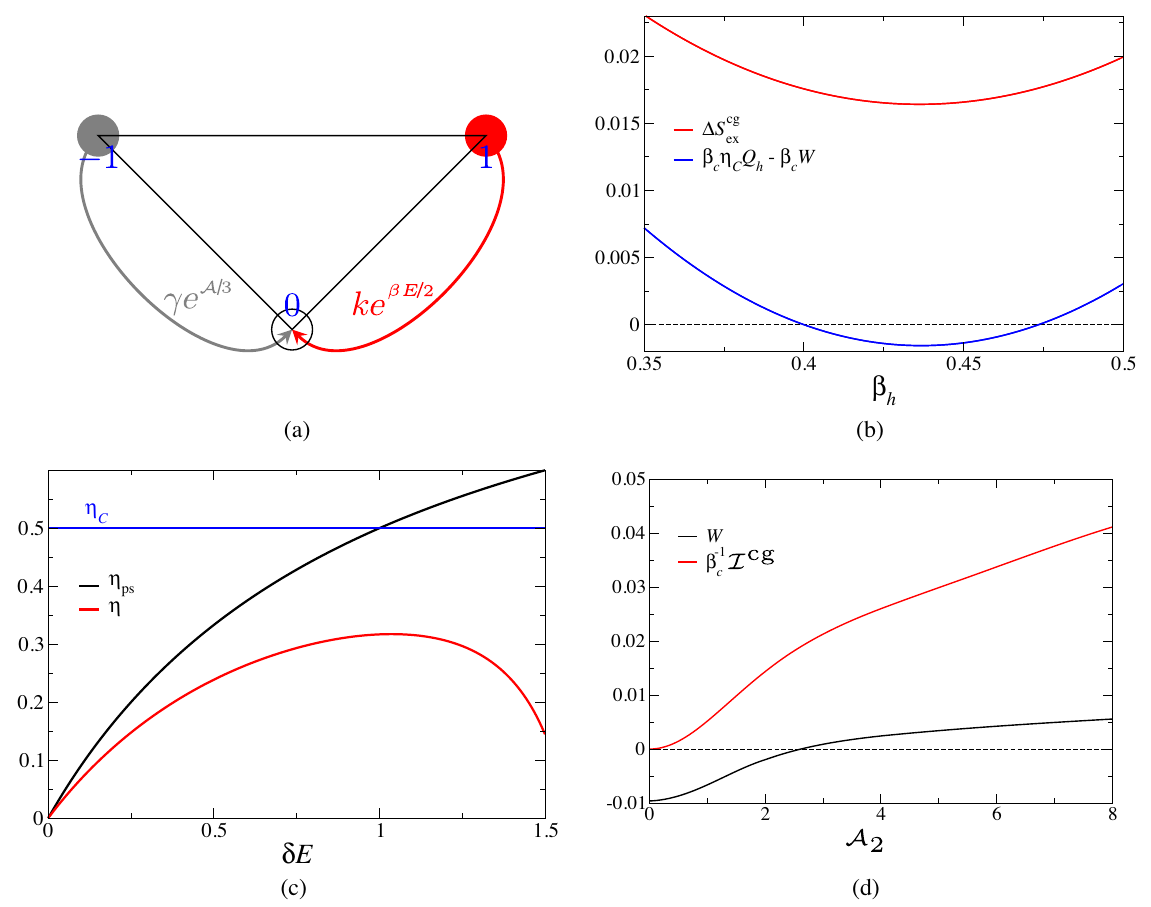
FIG. 6. (a) Depiction of the model for two interacting particles for the case the observable particle (in red) is at position x ¼ 1 and the hidden particle (in gray) is at position a ¼ − 1 . The particles can jump to position 0 with the rates given herein. (b) The quantities β η Q − β W , which can be negative for an active heat engine, and Δ S cg c C h c and A 2 ¼ 10 = 3 . (c) Efficiency η and pseudo-efficiency η ps as functions of δ E and compared to the Carnot bound for β h ¼ 0 . 5 , A 10 = 3 . (d) Work W and its upper bound ð β 2 ¼ plots β c ¼ 1 , A 1 ¼ 0 , E ¼ 1 , k ¼ 10 , and γ ¼ 1